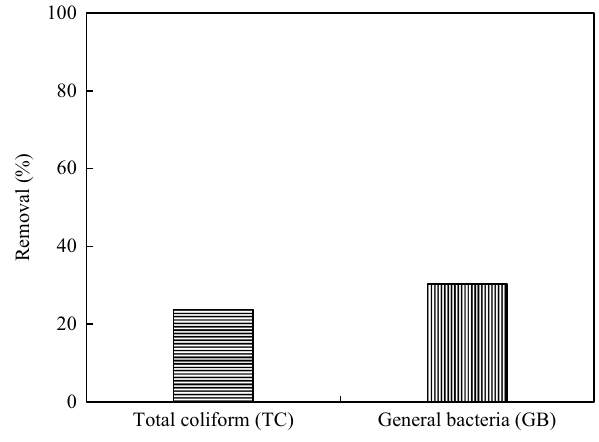
Fig. 8 TC and GB removal performances through filtration with the terminal voltage of + 1.0 V and at the filtration hydraulic loading of 283 L/m 2